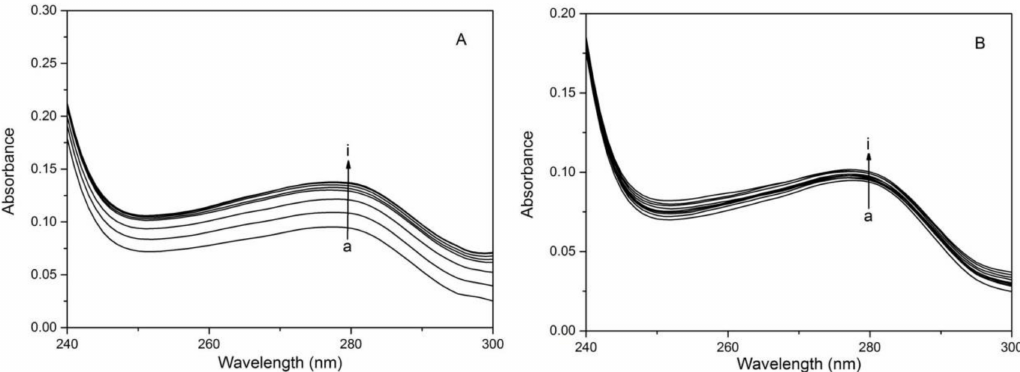
Figure 3. Absorption spectra of HSA with and without 1,3,6,8-tetrabromocarbazole or 3-bromocarbazole. ( A ): HSA-3-bromocarbazole; ( B ): HSA-1,3,6,8-tetrabromocarbazole), C HSA = 2 × 10 − 6 M; (a–i) 1,3,6,8-tetrabromocarbazole or 3-bromocarbazole concentrations were 0, 0.1, 0.2, 0.3, 0.4, 0.5, 0.6, 0.7 and 0.8 × 10 − 6 M, respectively.